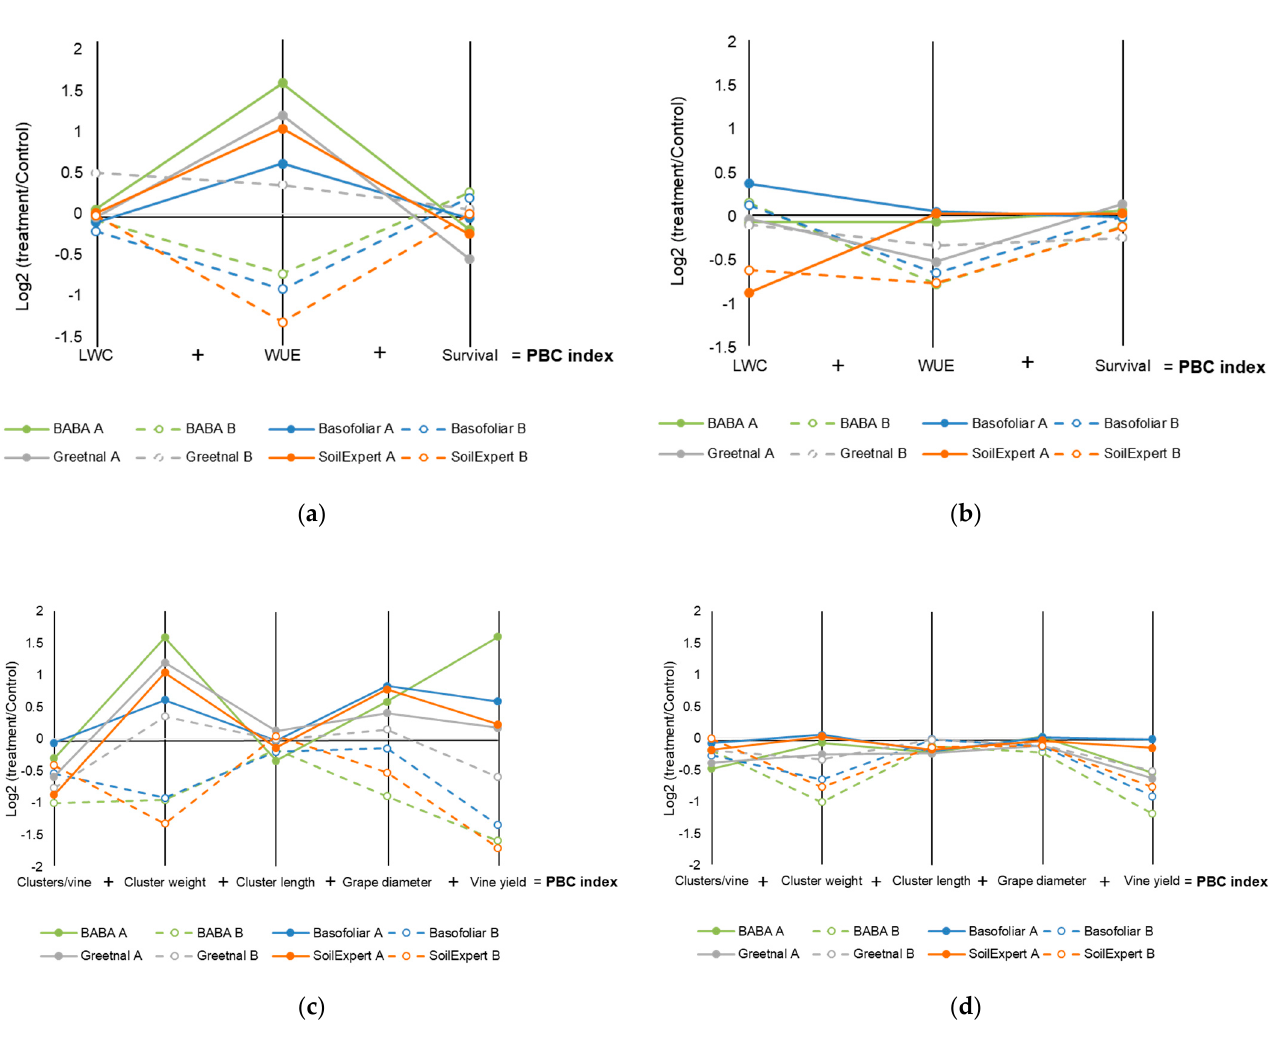
Figure 5. Parallel plot representing the LWC and survival as the log2 of the ratio between the treatment and control in plants of Vitis vinifera var. Tempranillo from two subplots (A and B) sprayed with distilled water (C), BABA, or three commercial biostimulants (Greetnal, Basofoliar, or SoilExpert) in the ( a ) 2018 and ( b ) 2019 seasons. Parallel plot representing the production as the log2 of the ratio between the treatment and control in the ( c ) 2018 and ( d ) 2019 seasons.